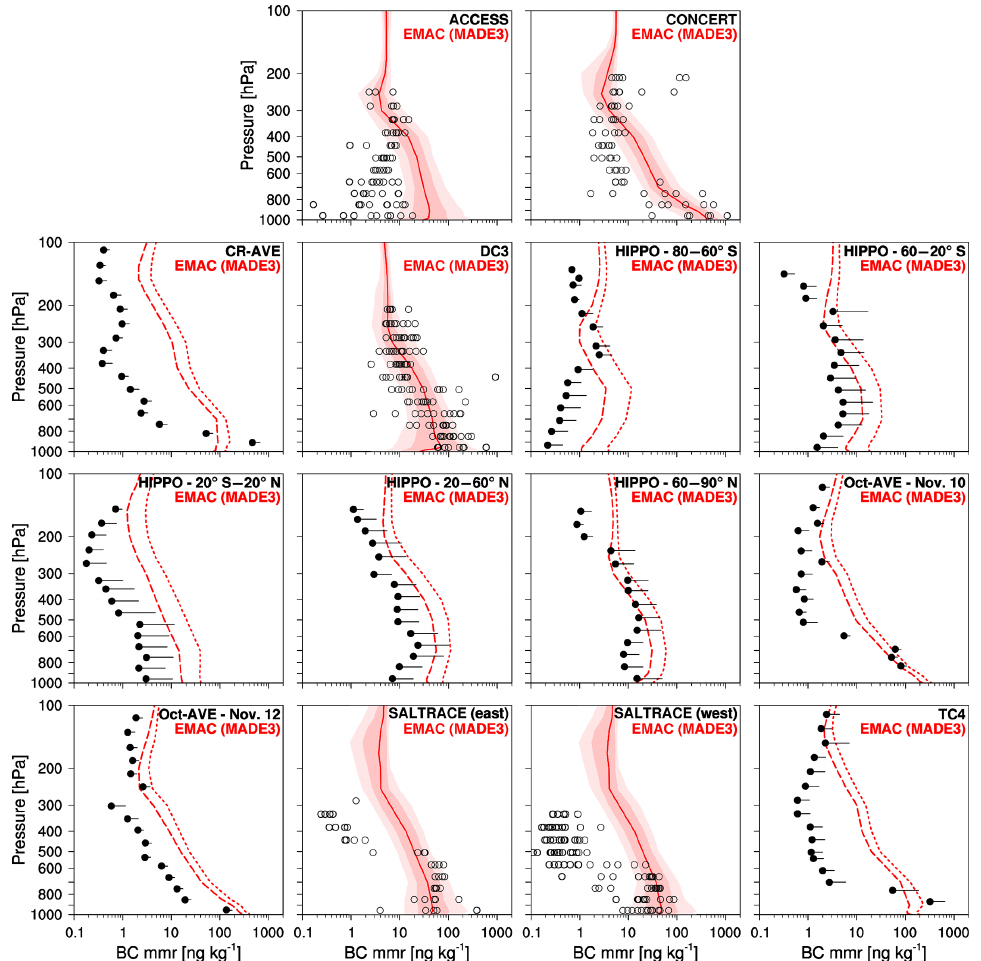
Figure 5. BC mass mixing ratios (mmrs) in the EMAC simulation with MADE3 (red) vs. measurements during various field campaigns (black). Dashed lines and filled circles represent mean values; dotted lines and whiskers represent standard deviations, which are only shown in the direction of larger values for clarity. Solid lines stand for median values. Light and dark shadings indicate the 10th to 90th, and 25th to 75th percentiles, respectively. Hollow circles are the median values of individual flights. Descriptions of the campaigns are provided in Table 4 and in the text. Note that the vertical axis of the left plot in each row applies to the other plots of that row as well, and the horizontal axes of the plots in the lowermost row also apply to the plots in the other